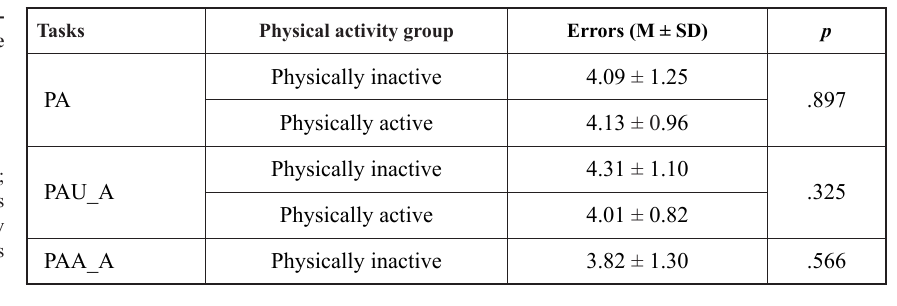
Note. * p > .05; PA – simple posture; PAU_A/ PAA_A – clenched legs legs closed eyes with the memory task/clenched legs legs open eyes with thememory task. Table 4. Correlation between physical activity, posture and